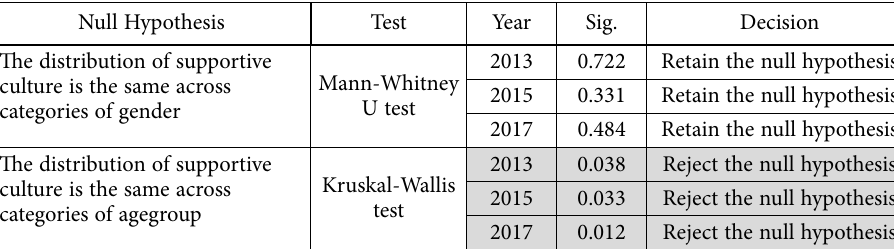
Table 6. Hypotheses verification – supporting culture (source: Prepared by the authors) Null Hypothesis Test Year Sig.